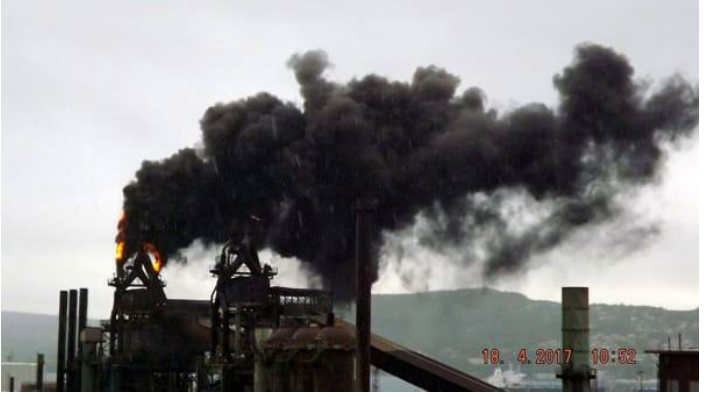
Figure 1. Servola Ironmaking Plant—Opening of the two BF 3 bleeders seen from the houses near the plant.